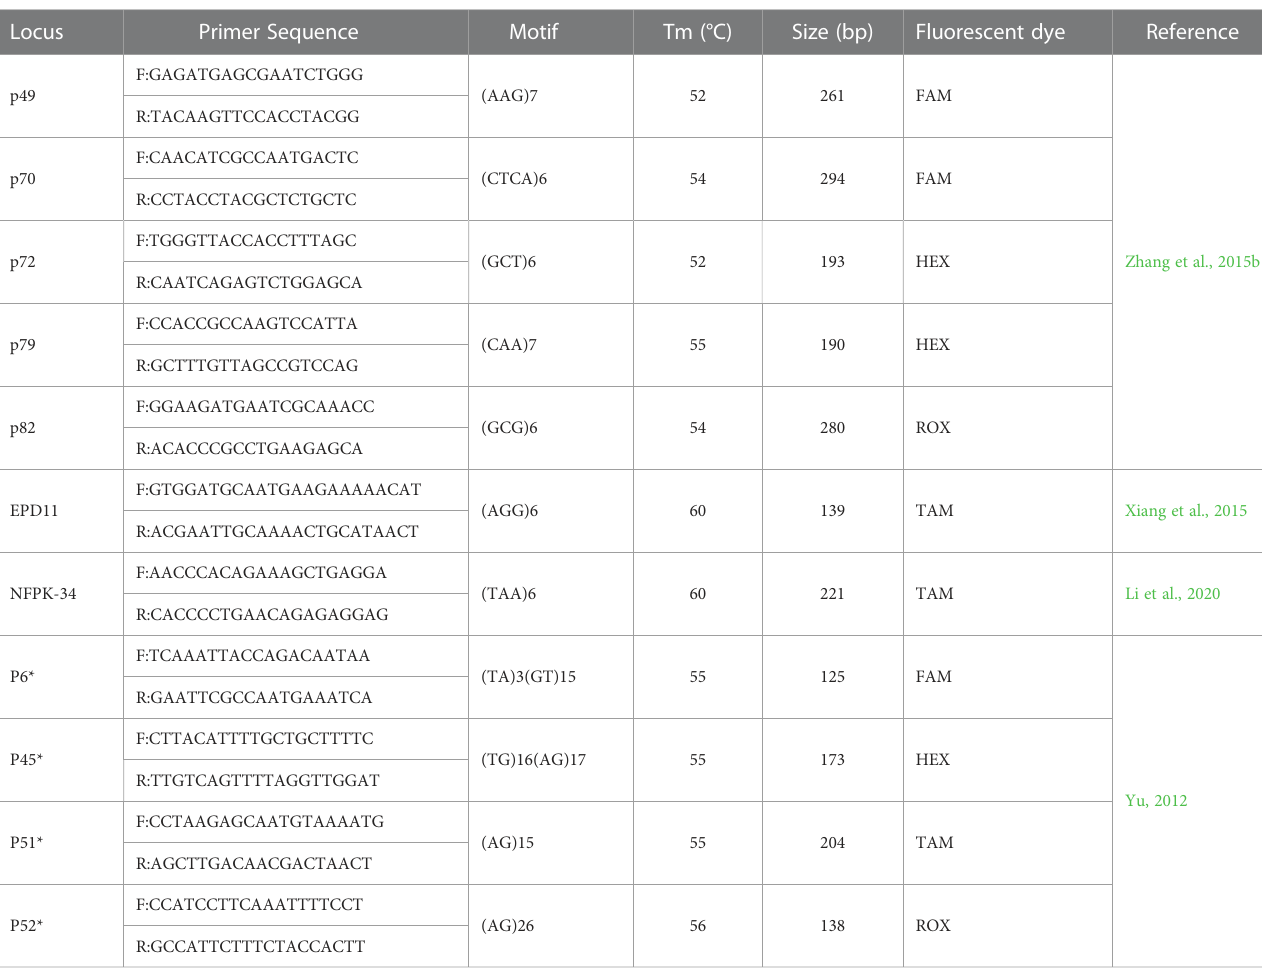
TABLE 2 SSR primer information of Korean